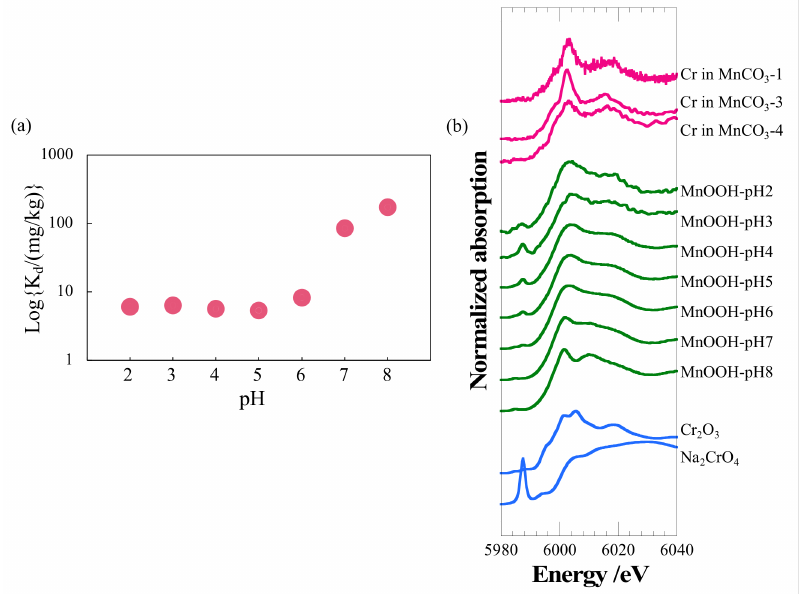
Figure 8. Results of Cr–MnOOH adsorption experiment. ( a ) Distribution coefficient of Cr 3+ to MnOOH plotted as a function of pH. The vertical axis shows the concentration of Cr in the MnOOH (solid phase) relative to the concentration of Cr in the liquid phase in the logarithmic scale. At pH < 6, the Cr was not incorporated into the solid phase. The adsorption began at pH = 6 and increased at pH > 7. ( b ) Cr K-edge XANES spectra obtained from solid phase samples at each pH level. For comparison, the Cr-XANES spectrum of the Mn-enriched area in the iddingsite is shown in pink. The spectra of trivalent and hexavalent Cr compounds are shown in blue as reference